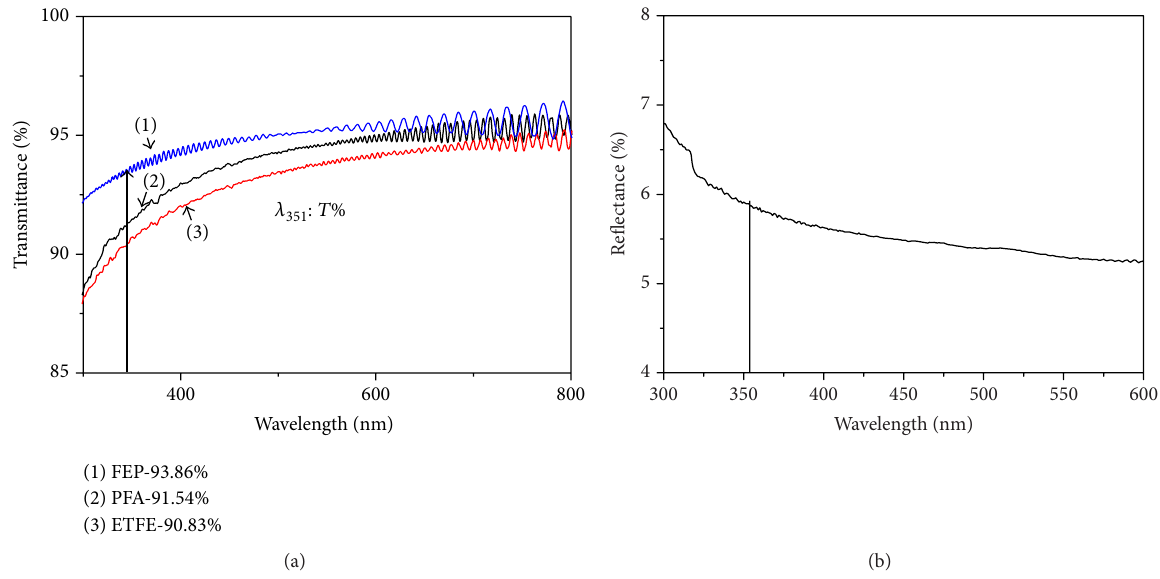
Figure 1: (a) Transmittance and (b) reflectance of the three kinds of fluoride polymer films range from 300 nm to 800